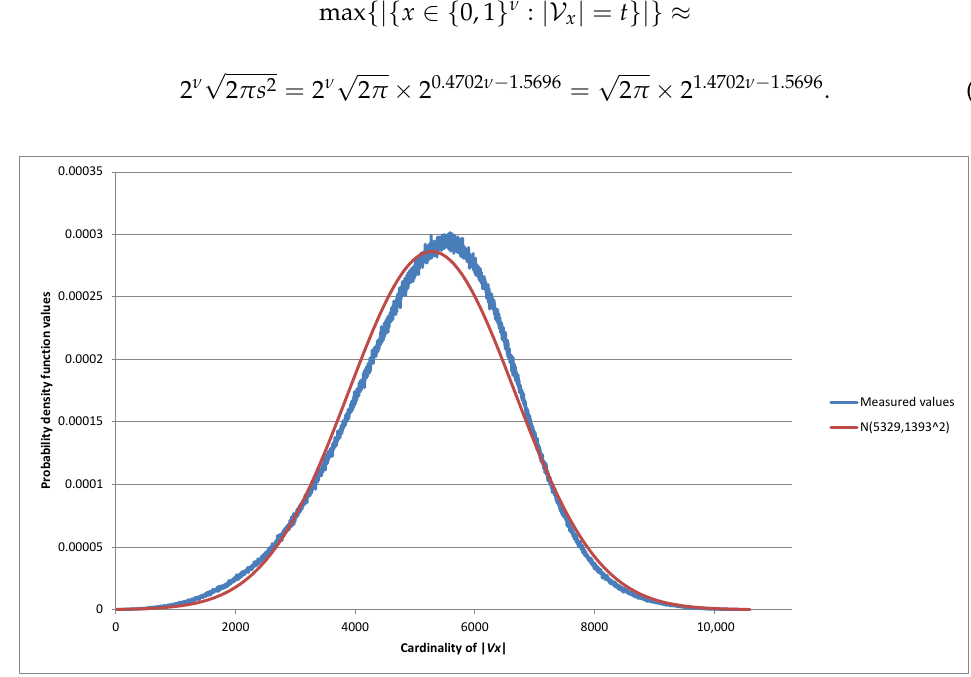
Figure 3. The estimate of the density function of a random variable X 26, t .